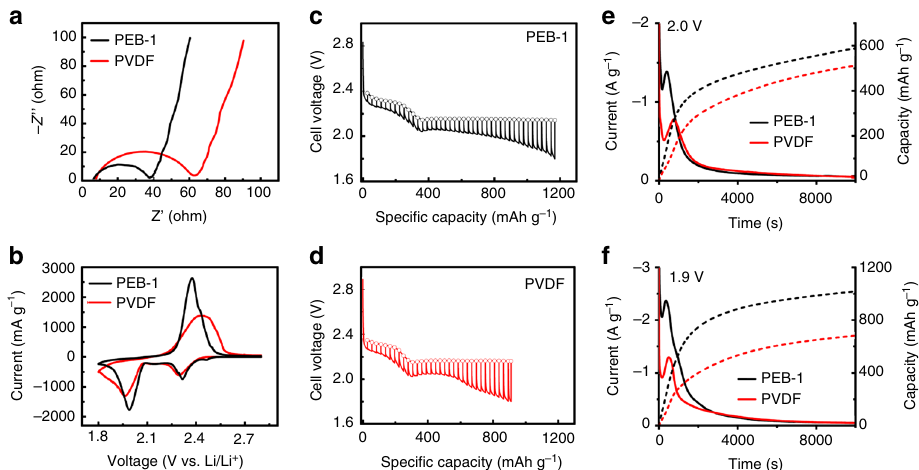
Fig. 2 Improved cell kinetics enabled by PEB-1 compared with conventional PVDF binder. a Electrochemical impedance spectroscopy (EIS) for Li – S cells after cell assembly. b Cyclic voltammetry (CV) for Li – S cells after cell assembly. c , d Galvanostatic intermittent titration technique (GITT) for Li – S cells on the fi rst discharge. e , f Potentiostatic discharge experiments for Li – S cells on the fi rst discharge, after being equilibrated at 2.3 V for 6 h. The cell voltage was then lowered to either 2.0 V or 1.9 V to initiate the nucleation and growth of Li 2 S on the embedded current